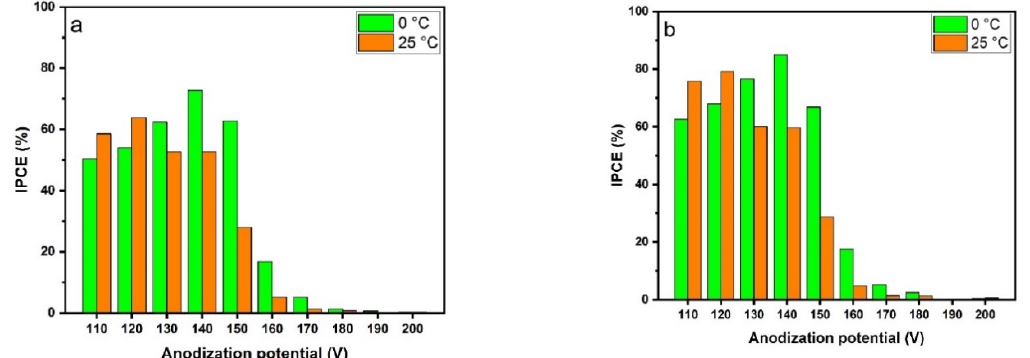
Figure 7. Photocurrent density of TiO 2 films obtained at 0 °C ( a ) and 25 °C ( b ).